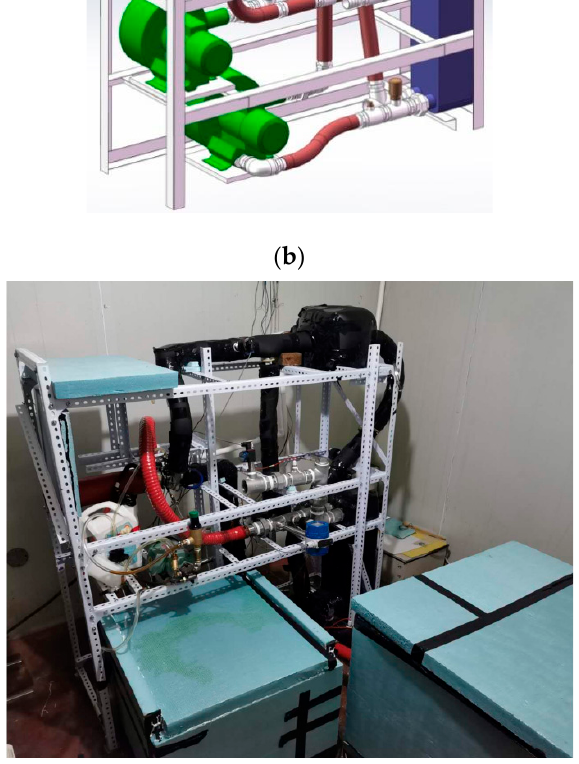
Figure 6. Comparison of calculation and experimental results under different conditions (45 °C/35 °C hot water temperature).